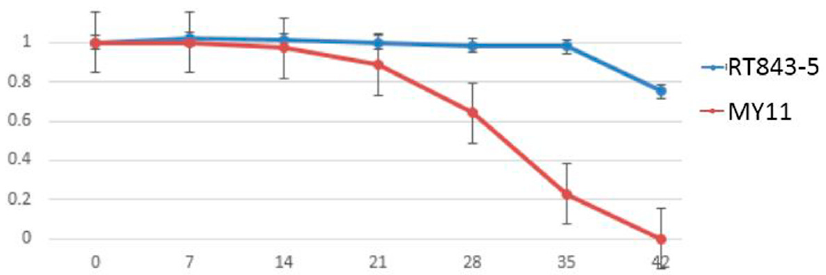
Figure 9. Differences in the NPI (net Pn index) between RT843-5 and MY11 during leaf senescence after anthesis. The Y-axis shows the values of the NPI, and the numbers on the X-axis show the days after anthesis.